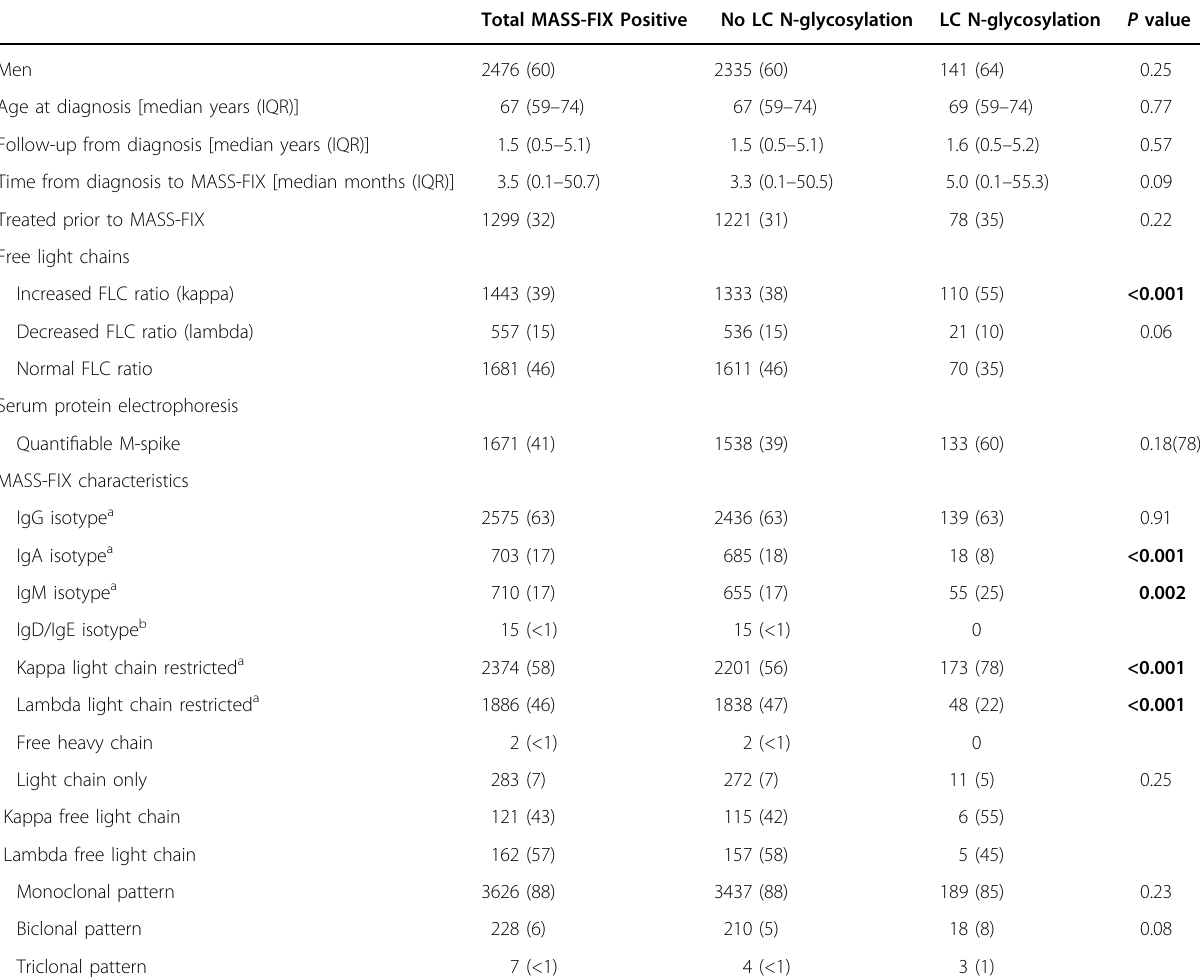
Table 1 Demographic and laboratory characteristics of 4118 MASS-FIX positive patients, strati fi ed by non-LC N-glycosylated (3897) and LC N-glycosylated (221)